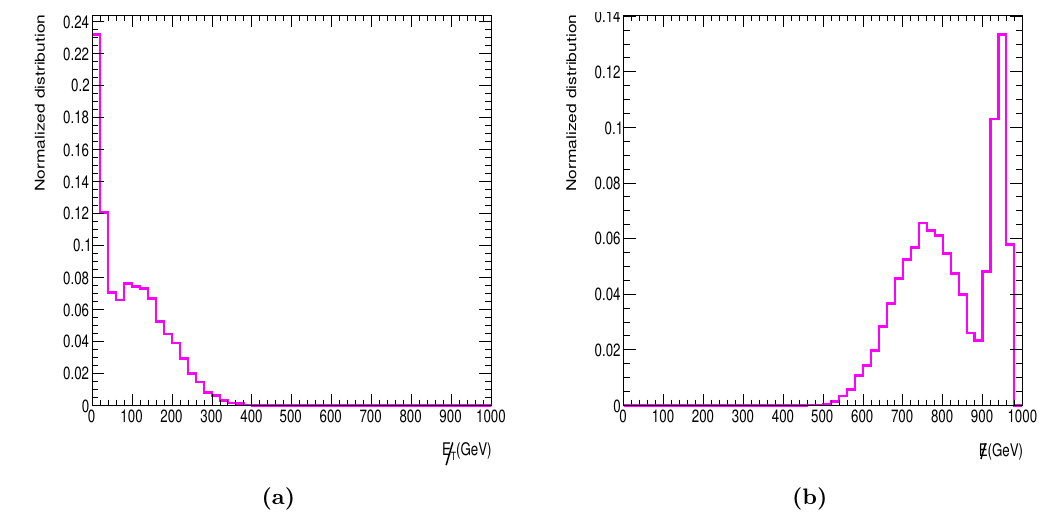
Figure 4. Same as figure 3, with { m DM duction cross-section of the lighter HDSP pair is assumed half of that for the heavier HDSP pair √ at s = 1000